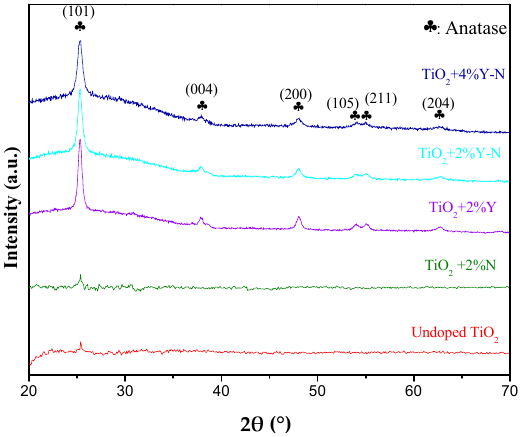
Figure 2. GXRD patterns of the undoped TiO 2 and 2%, 4% Y and/or N doped TiO 2 thin films annealed at 400 °C.